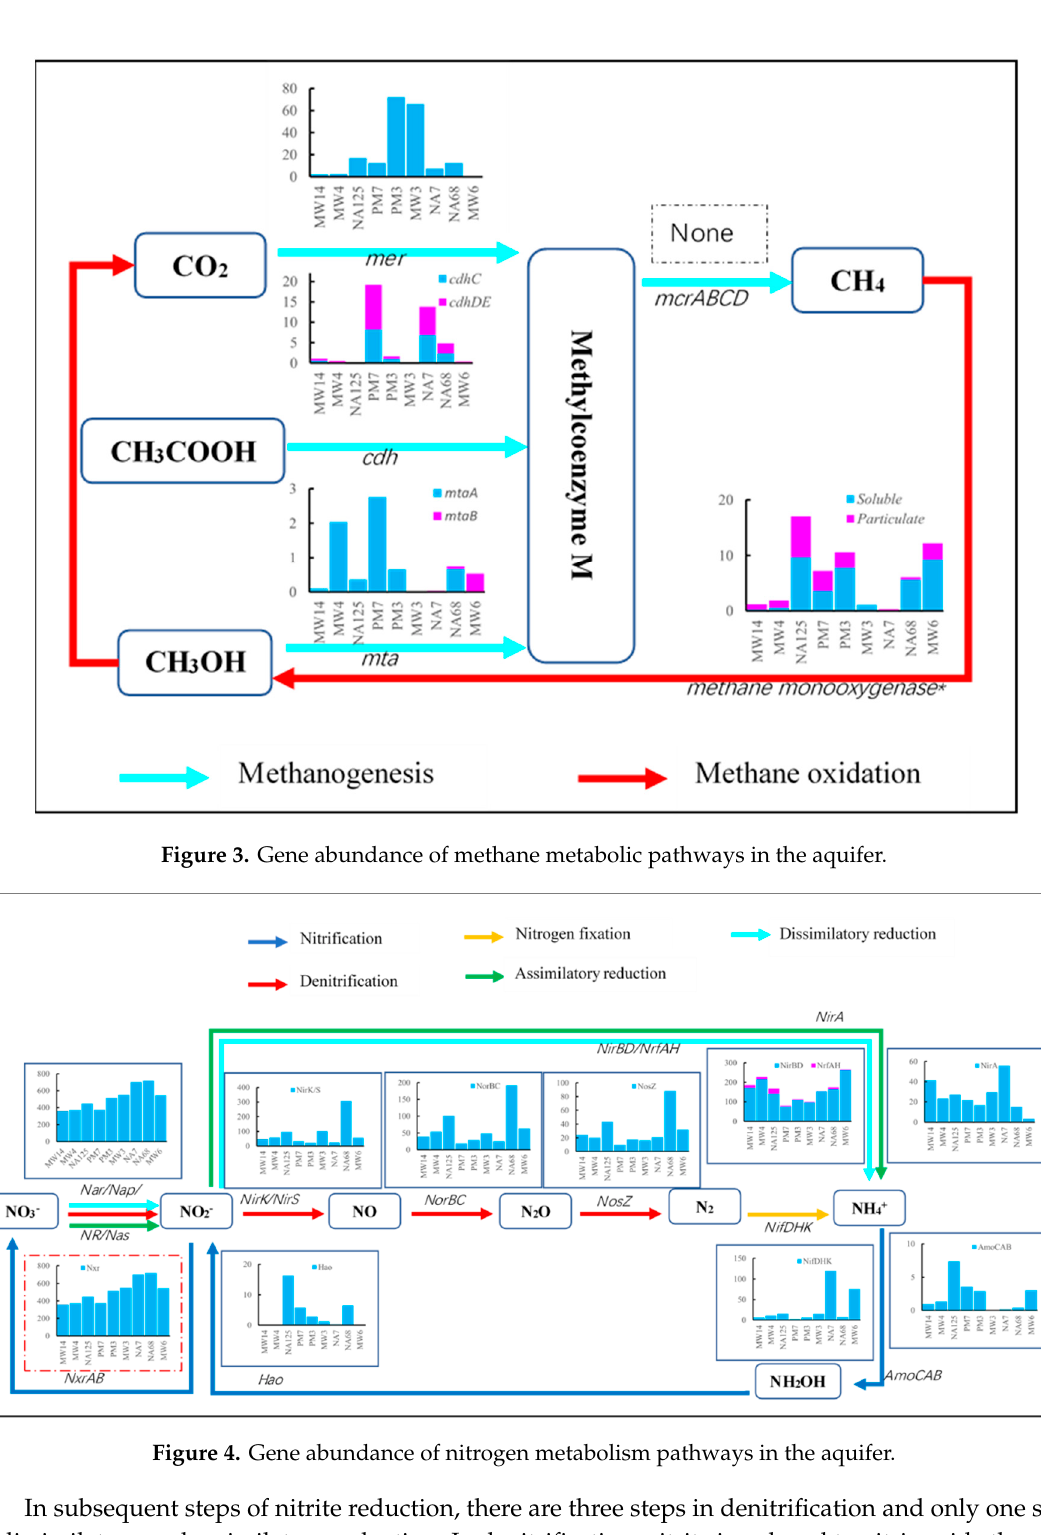
Figure 4. Gene abundance of nitrogen metabolism pathways in the